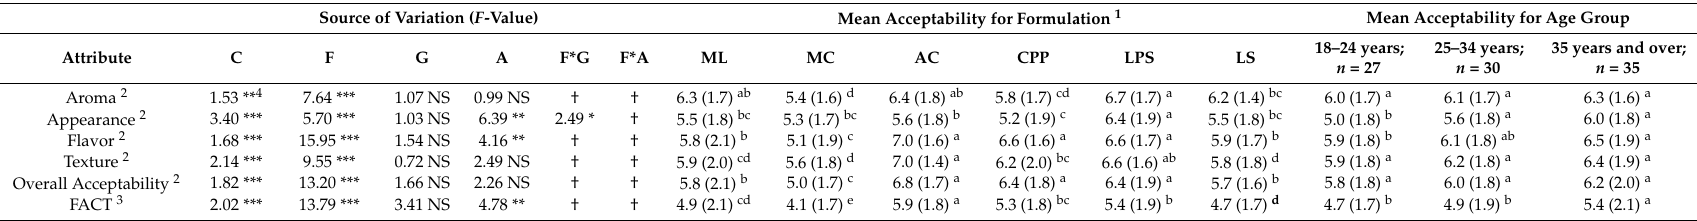
Table 4. Four-way ANOVA for Consumer (C) n = 92; Formulation (F) n = 6; Gender (G) n = 2; Age Group (A) n = 3 for acceptability of lentil formulations with mean values for formulation and age